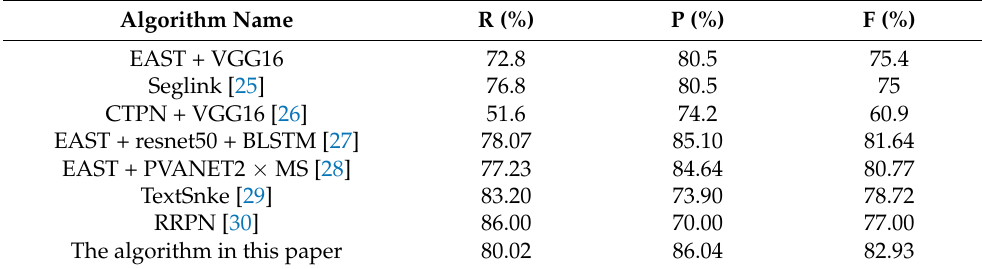
Table 1. Comparison results of R, P, and F-value evaluation indexes of several